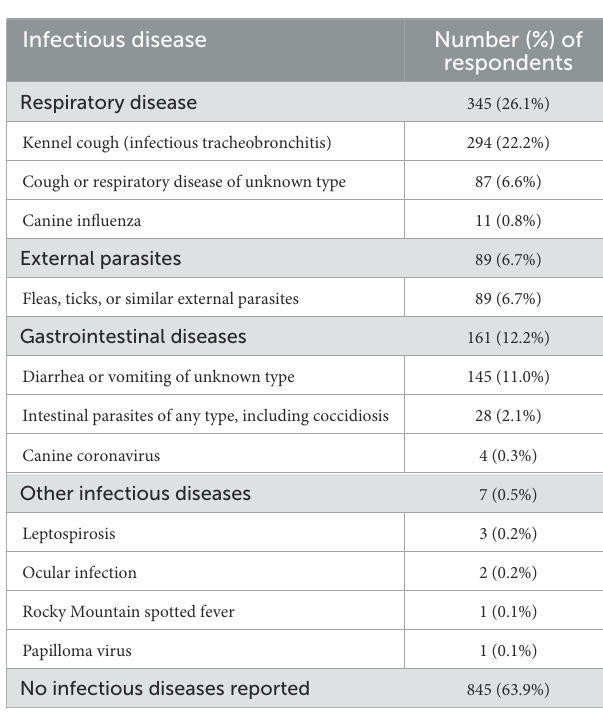
TABLE 5 Percentage of respondents reporting any history of respiratory disease, external parasites, or gastrointestinal disease following an agility